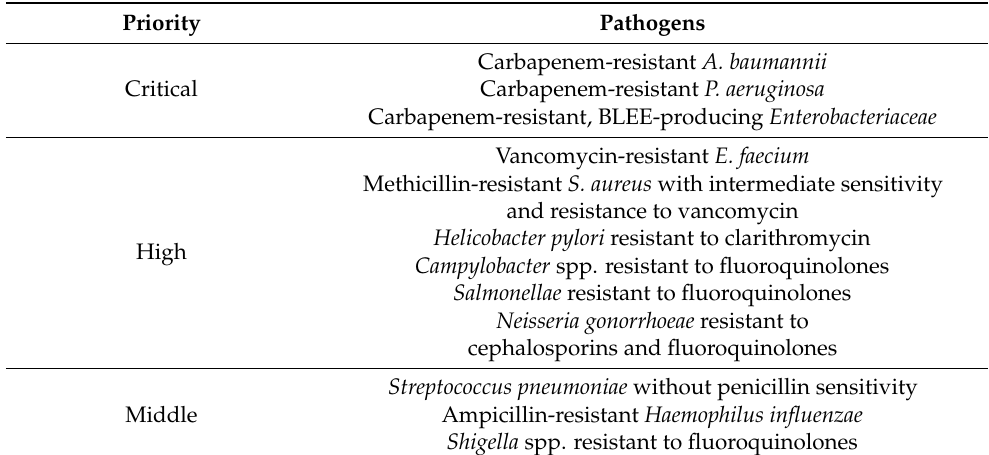
Table 1. List of priority pathogens for research and development of new